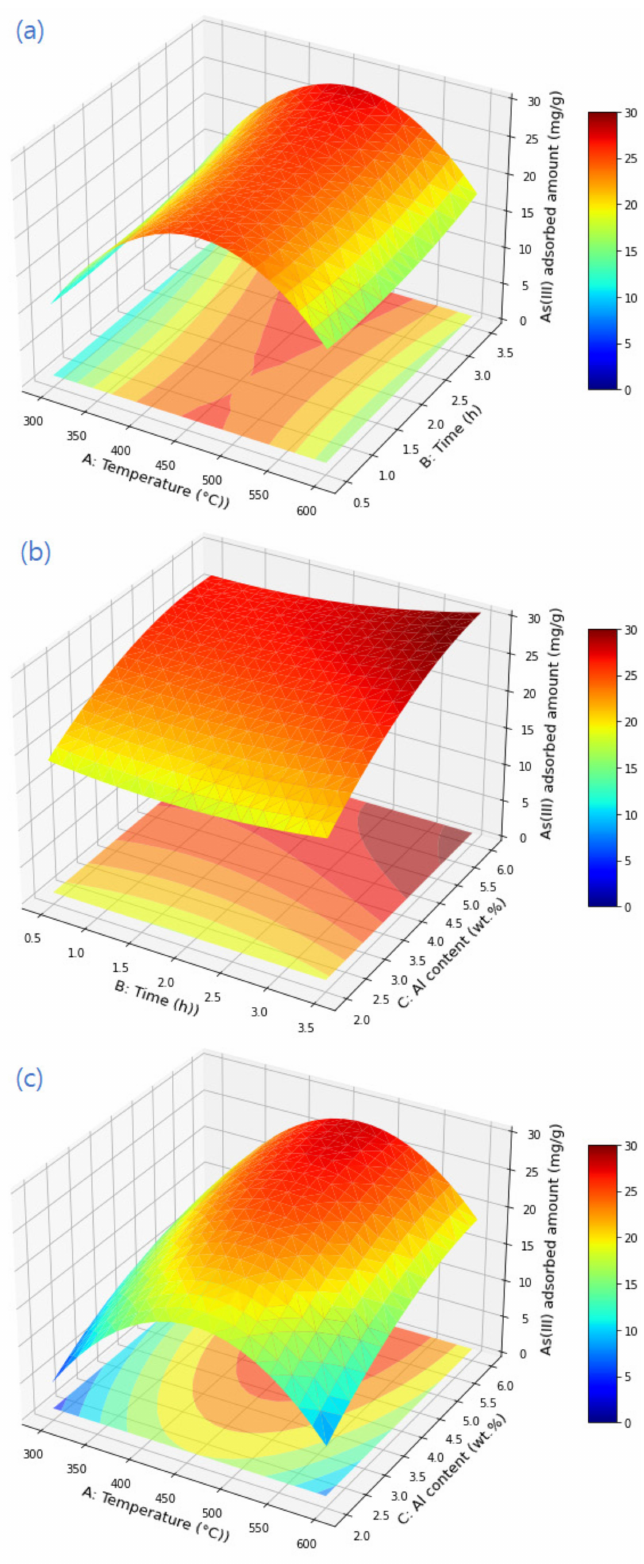
Figure 1. Estimated response surface for the amount of As(III) adsorbed onto a unit mass of Al- modified food waste biochar (AL-FWB), showing the effect of ( a ) contact time (h) and temperature ( ◦ C), ( b ) Al content (w/w %) and contact time (h), and ( c ) Al content (w/w %) and temperature ( ◦